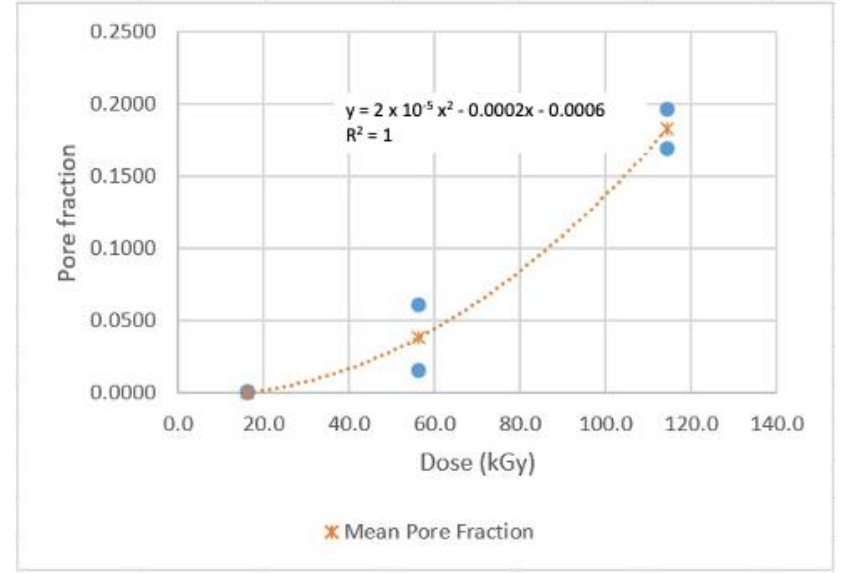
Figure 27. Porosity (pore fraction) of the 16 – 114 kGy wafer samples.